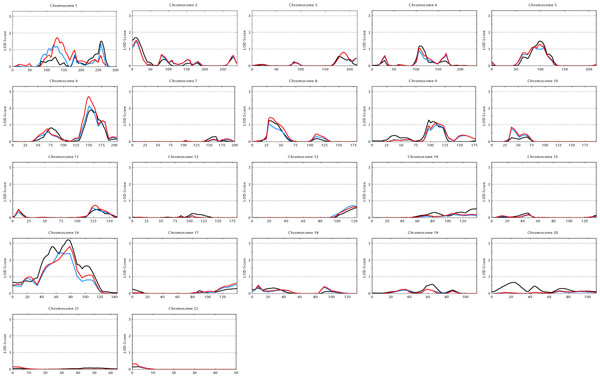
Multi-point LOD scores for BMI. Analysis method: SOLAR (black line), MERLIN-VC (red line), MERLIN-REGRESS (blue line). For ease of presentation, negative LOD scores from MERLIN-REGRESS were set to 0. Positions are given in cM.